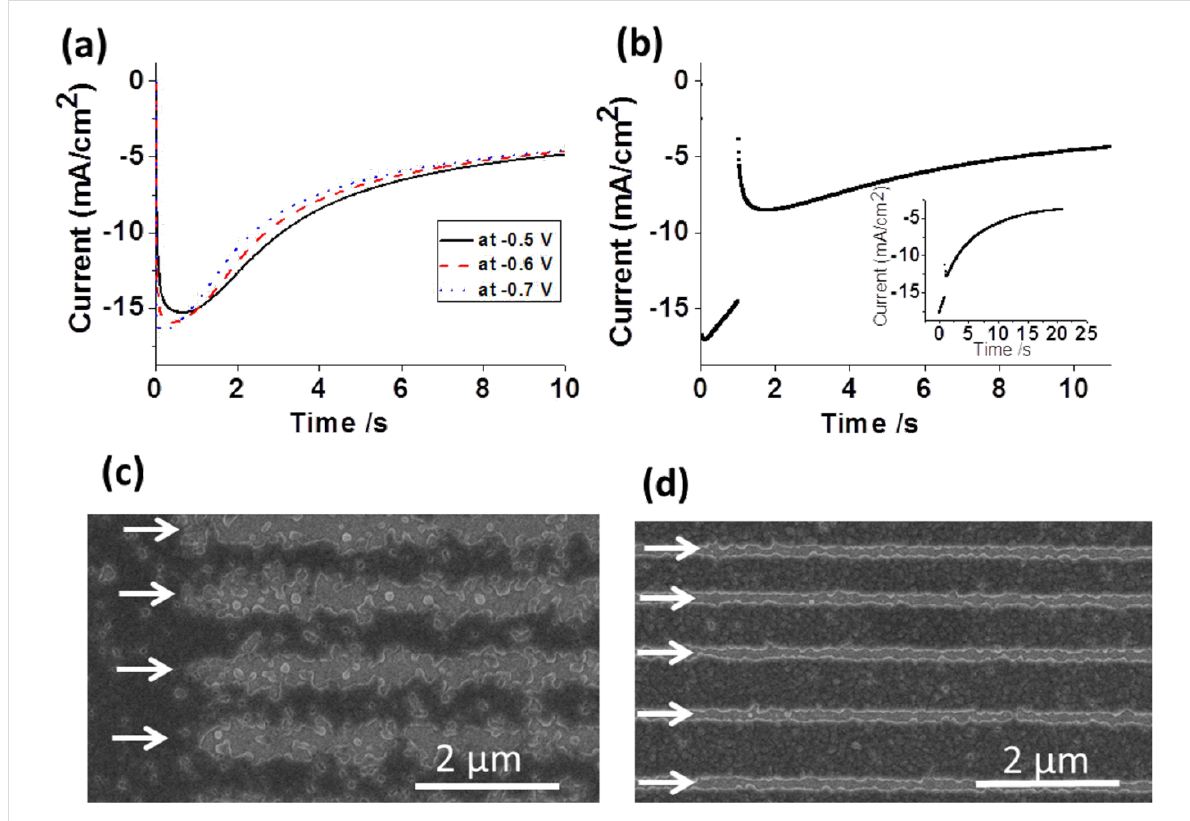
Figure 4: (a,b) Chronoamperograms of single potential (a) and double potential (b) deposition processes on a uniform MBP0-SAM on Au/Si. Poten- tials of I – t curves in (a) are − 0.5 V (black line), − 0.6 V (red dashed line) and − 0.7 V (green dotted line) and in (b) − 0.7 V for 1 s, − 0.35 V for 10 s on MBP0/Au/Si. For comparison an I – t curve for a clean Au/Si substrate and identical deposition conditions is shown in the inset. (c,d) SEM images of Cu deposition on e-beam-patterned SAMs. Lines indicated by arrows were written with an electron dose of 800 mC/cm 2 in both cases.